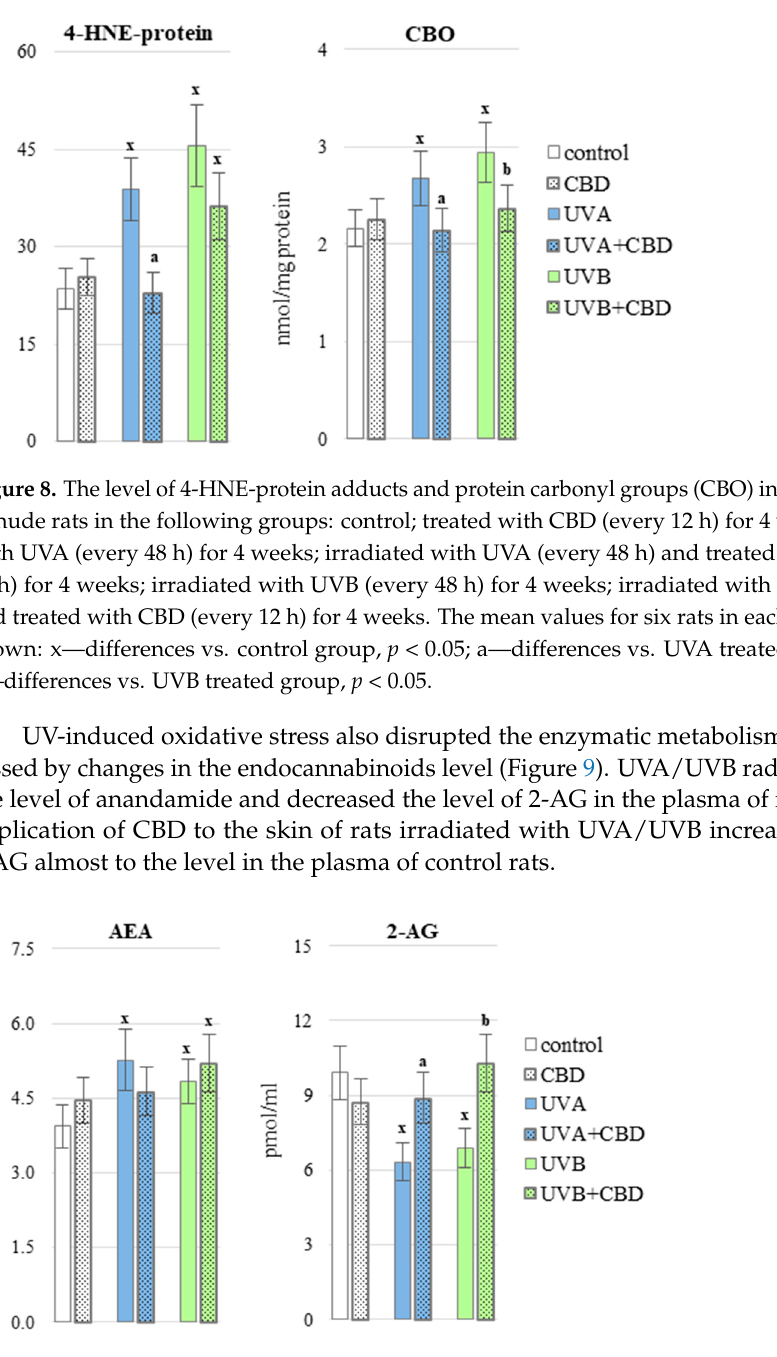
Figure 9. Endocannabinoids level AEA and 2 ‐ AG in the blood plasma of nude rats in the following groups: control; treated with CBD (every 12 h) for 4 weeks; irradiated with UVA (every 48 h) for 4 weeks; irradiated with UVA (every 48 h) and treated with CBD (every 12 h) for 4 weeks; irradiated with UVB (every 48 h) for 4 weeks; irradiated with UVB (every 48 h) and treated with CBD (every 12 h) for 4 weeks. The mean values for six rats in each group ± SD are shown: x—differences vs. control group, p < 0.05; a—differences vs. UVA treated group, p < 0.05; b—differences vs. UVB treated group, p < 0.05.